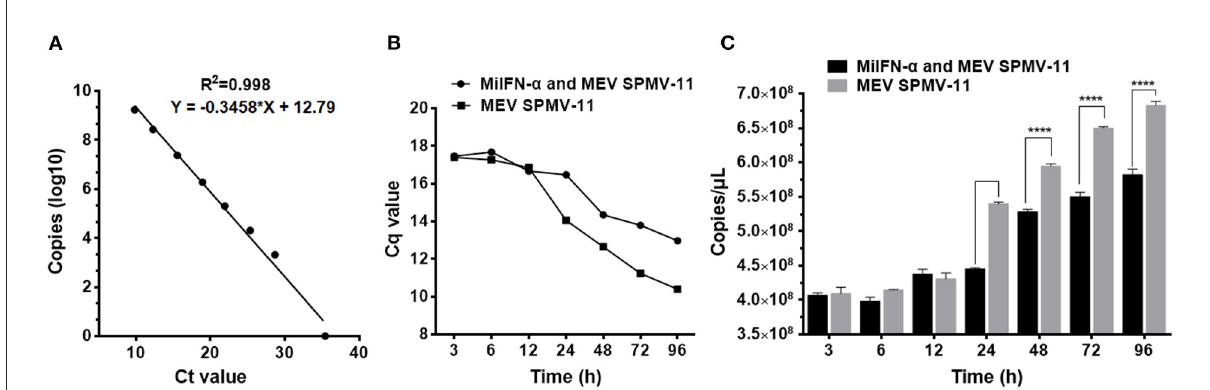
FIGURE8 MiIFN- α inhibits MEV SMPV-11 replication in vitro. (A) MEV Standard curve of quantitative real-time PCR. (B) Changes in Cq values. (C) Changes in copy number. ****, P ≤ 0.0001.